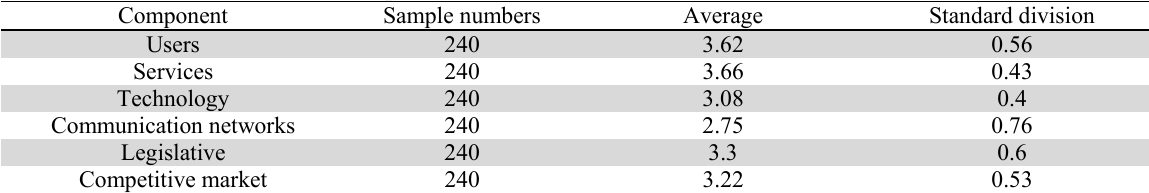
Statistical indicators for each